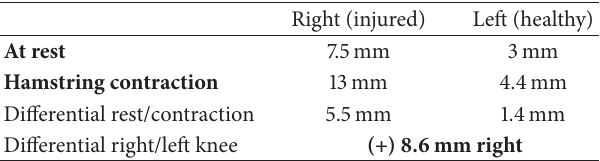
Table 1: Preoperative posterior laximetry on X-rays at 90 ∘ flexion with and without hamstring